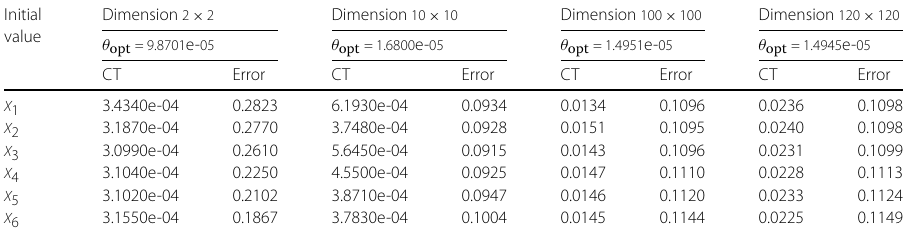
Table 2 Relative error and computational time for Example